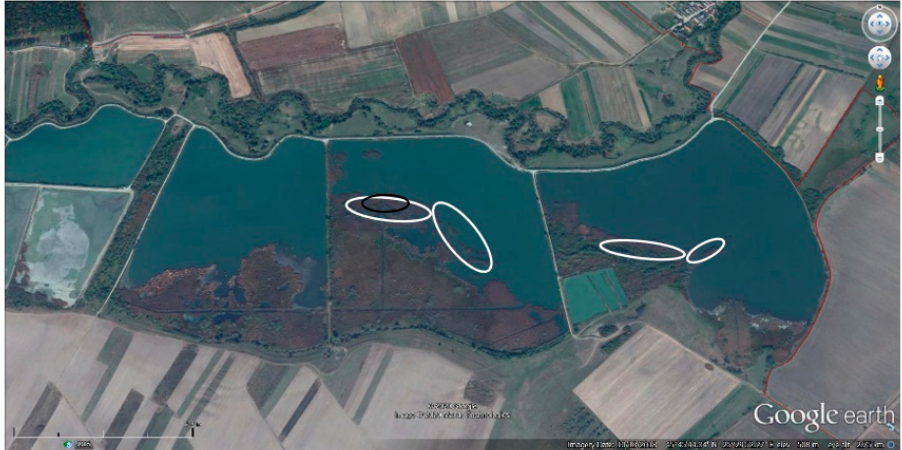
Figure 5. Colony location on fishponds from Dumbr ă vi ț a, 2010–2020 (black oval, Phalacrocorax carbo ; white oval, mixed, consisting of Microcarbo pygmaeus , Ardea cinerea , Nycticorax nycticorax , Egretta garzetta , and Ardeola ralloides ).